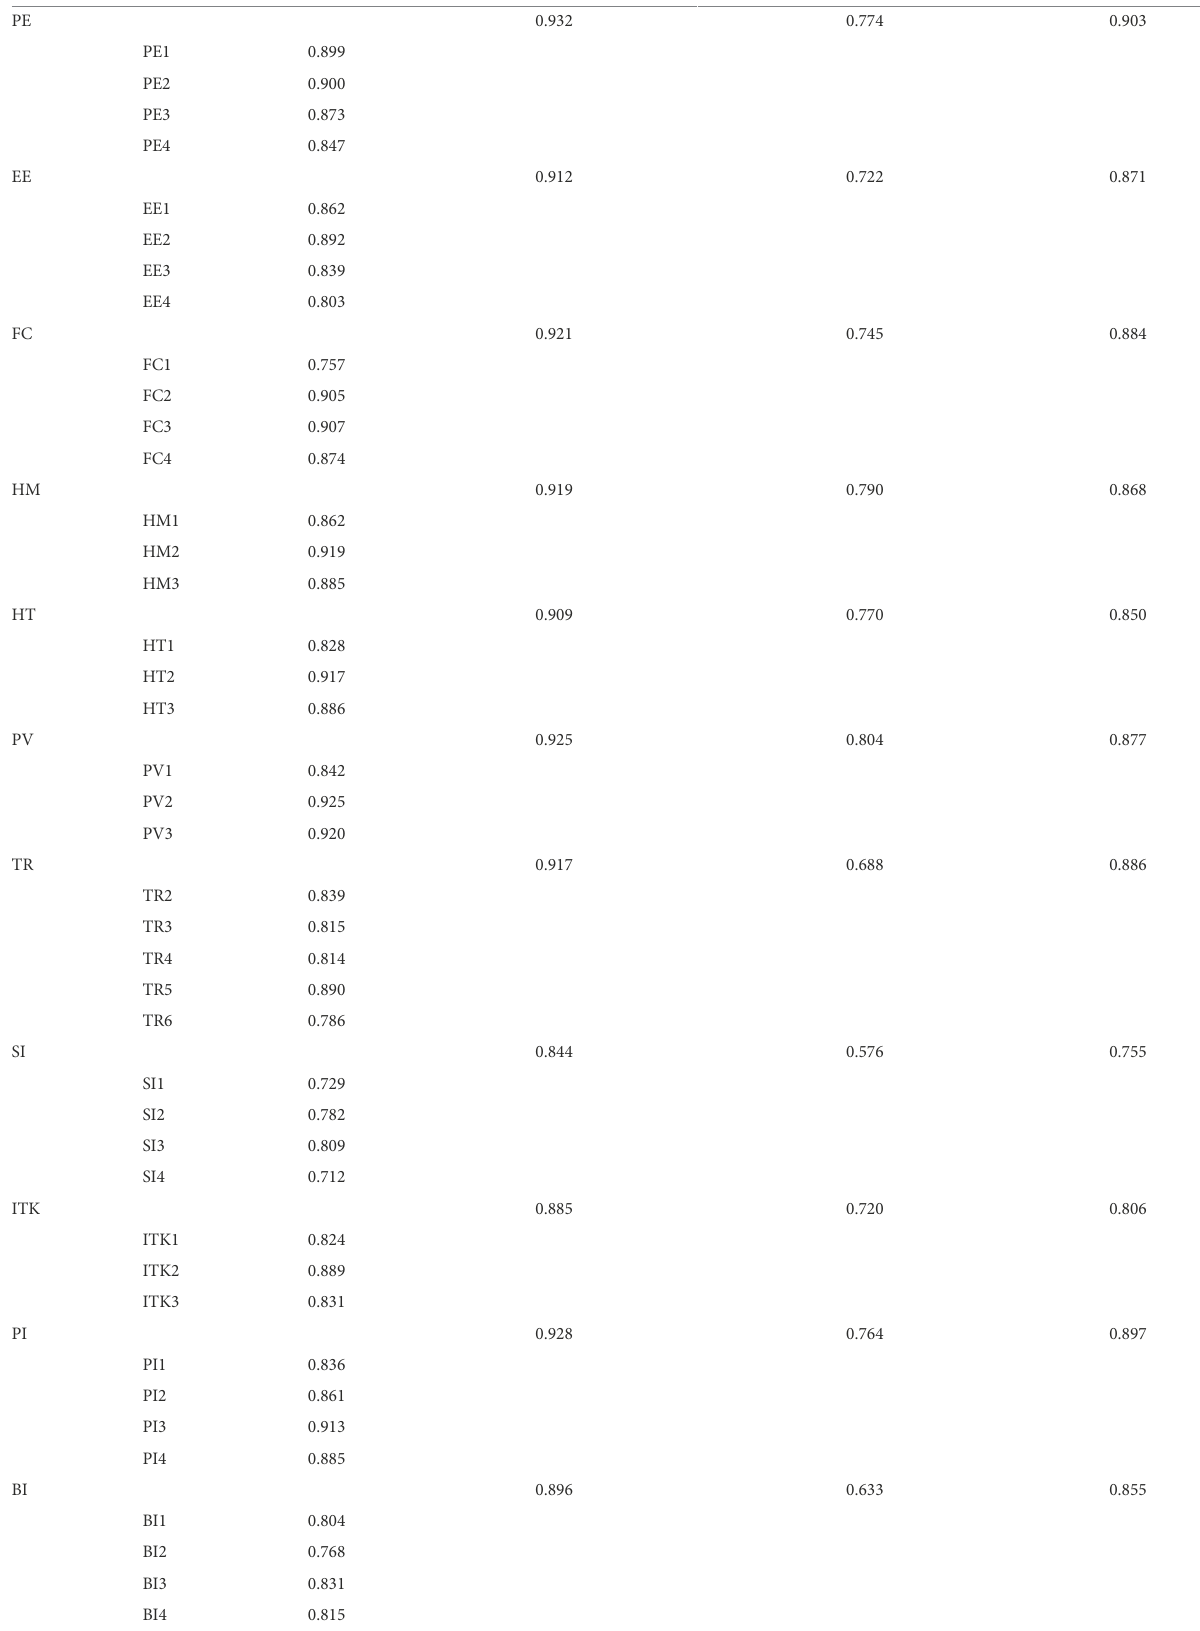
TABLE 3 Convergent validity of the